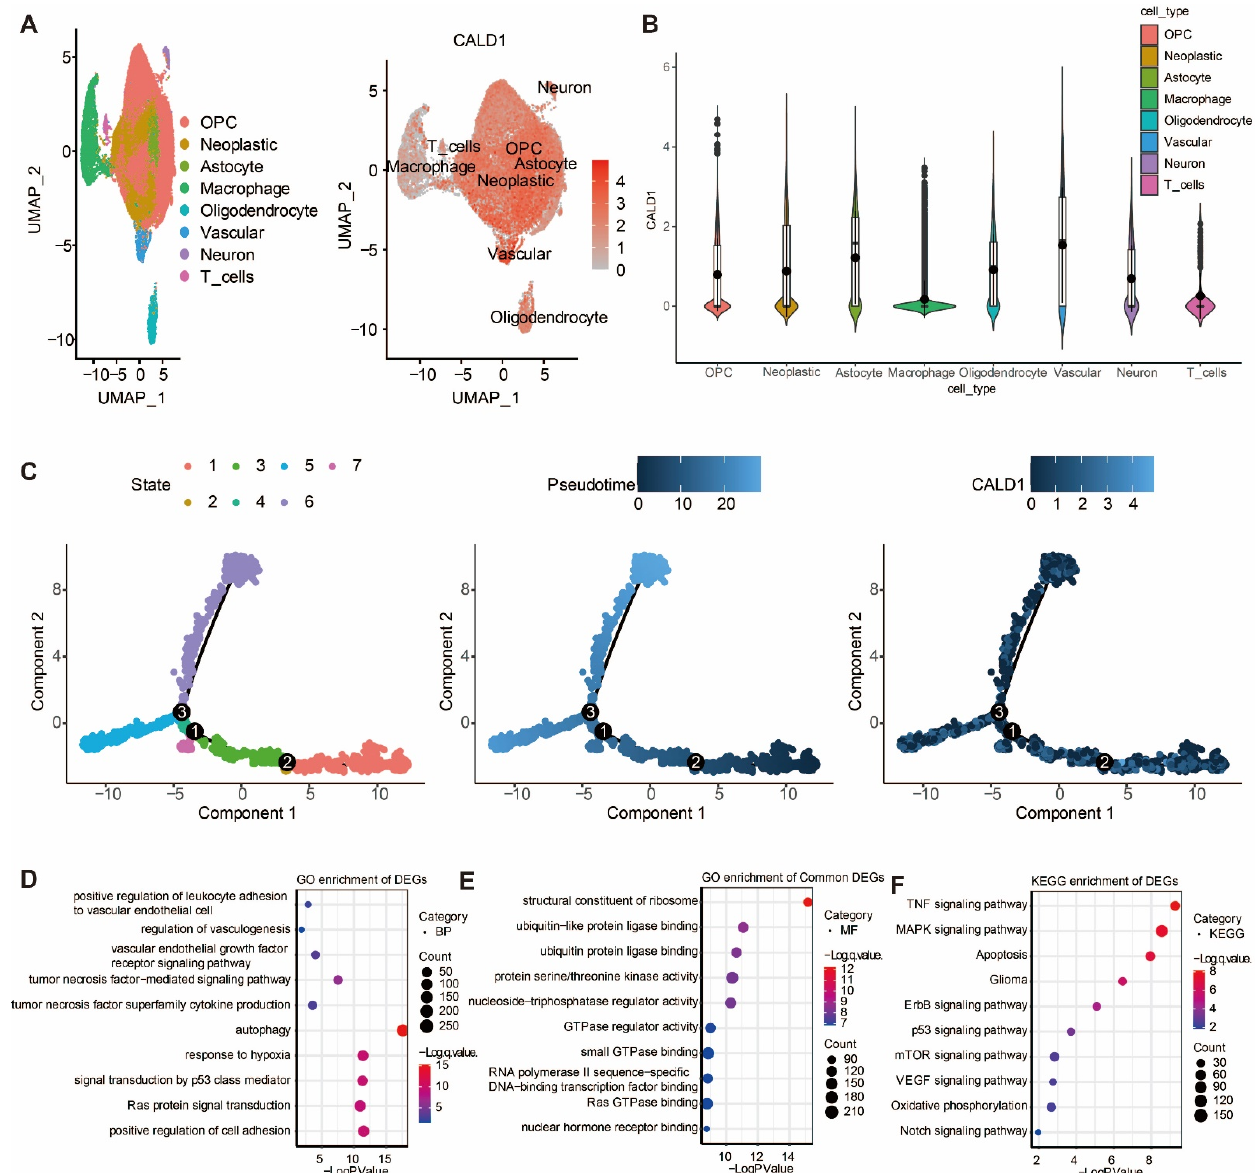
Figure 3. Single cell sequencing analysis in GBM microenvironment. ( A ) UMAP plot depicting eight cell clusters and the distribution of CALD1 expression levels within the eight cell clusters. ( B ) Violin plot exhibiting the relative expression level of CALD1 in eight cell clusters. ( C ) The single-cell trajectory of neoplastic cells contains four main branches. Cells are colored based on state (left), pseudotime (middle), and CALD1 (right). ( D ) GO enrichment analysis of CALD1 in BP in neoplastic cells. ( E ). GO enrichment analysis of CALD1 in MF in neoplastic cells. ( F ). KEGG enrichment analysis of CALD1 in neoplastic cells.